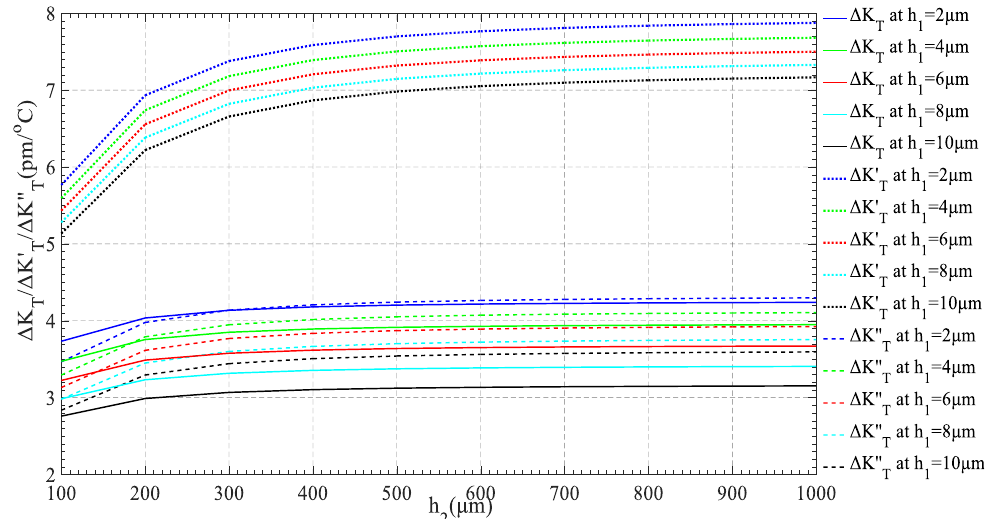
Figure 11. Effects of the coating thickness on Δ K T , Δ K ′ T and Δ K ′′ T .